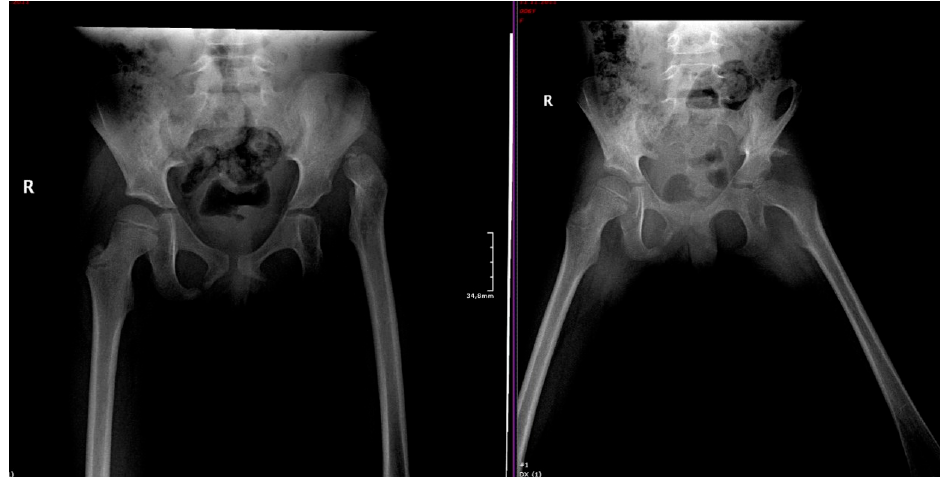
Figure 3. Proper acetabular orientation after a Salter osteotomy in a 5-year-old child. ( Left ) Pre- operative X-ray of the pelvis shows abnormal position of the femur head on the left side. ( Right ) Post-operative X-ray shows reorientation with good femoral head coverage and proper positioning of the bone graft. R: right side of patient; scale: 34.8 mm.